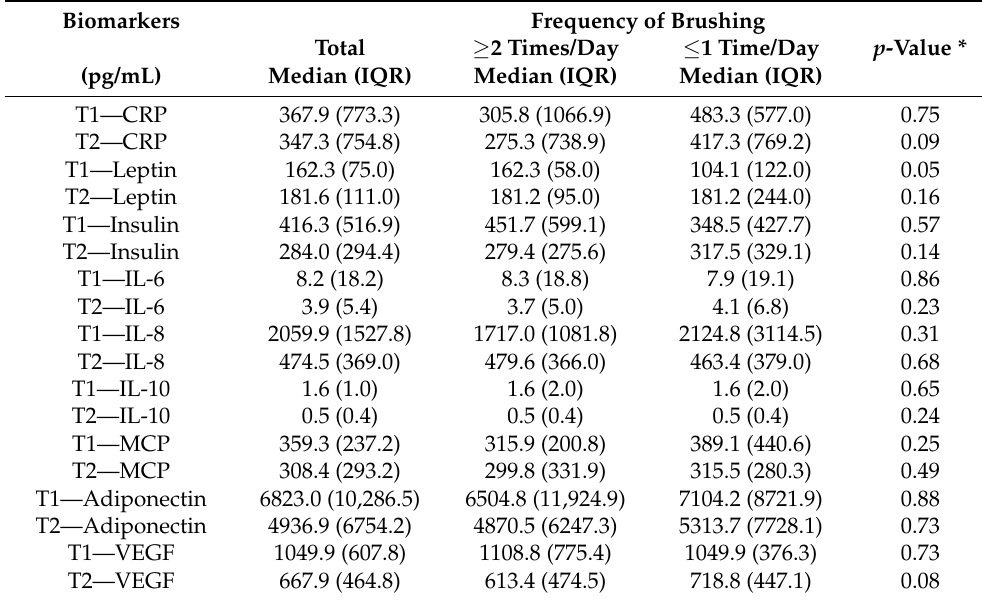
Table 3. Summary statistics for salivary biomarkers by brushing